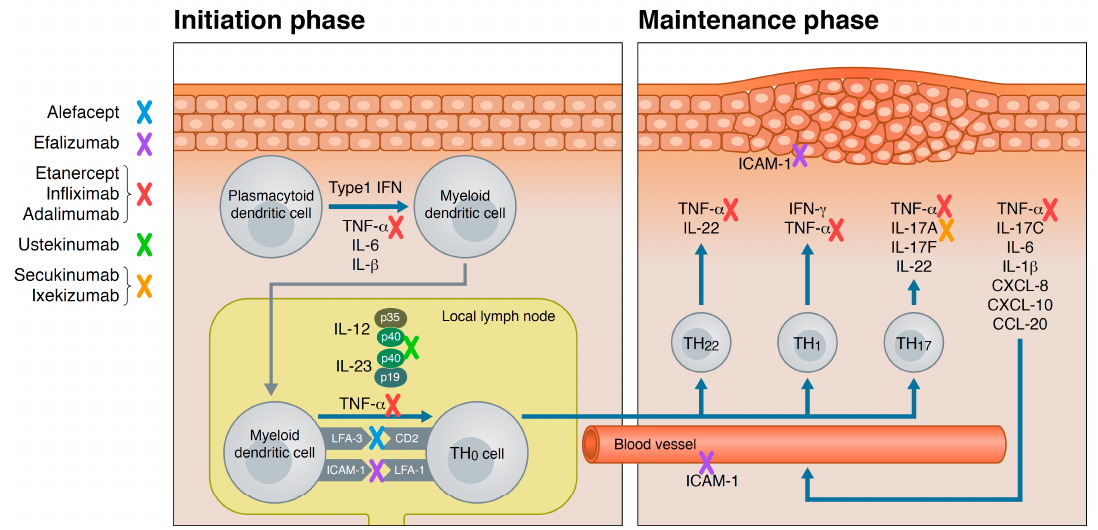
Figure 1. The targets for old and new biologics within the immunological process of psoriasis are illustrated. Included are biologics that have been approved by the United States Food and Drug Administration (as of June 2017). IFN: Interferon. TNF: Tumor necrosis factor. IL: Interleukin. LFA: Lymphocyte function-associated antigen. CD: Cluster of differentiation. ICAM: Intercellular adhesion molecule. CXCL: Chemokine (C–X–C motif) ligand. CCL: Chemokine (C–C motif) ligand.